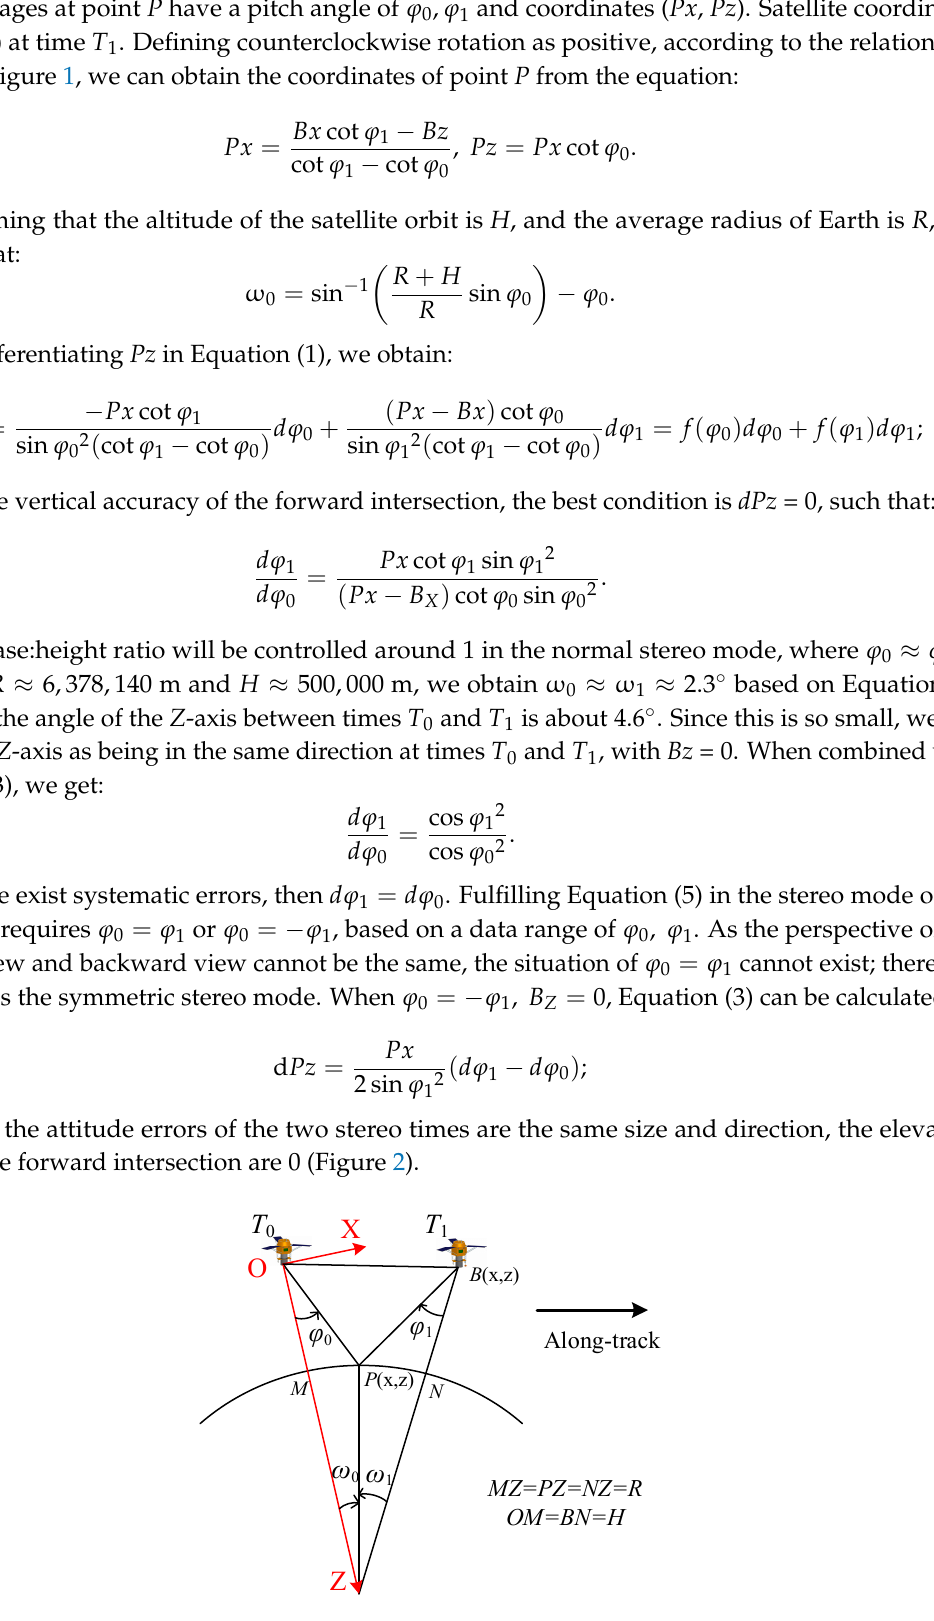
Figure 1. Schematic of camera stereo intersection.